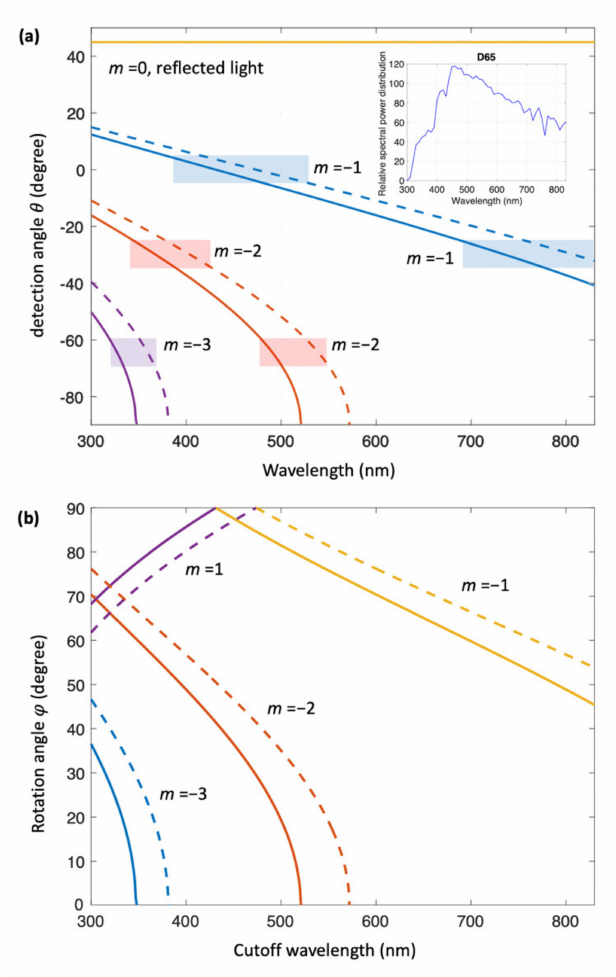
Figure 5. ( a ) Calculated m th order diffraction angles as a function of the wavelength of light. The ranges of the wavelength detected by three detection angles of 0 ◦ , − 30 ◦ , and − 65 ◦ are described by rectangular boxes filled with blue, red, and purple for m = − 1, − 2, and − 3, respectively. For these boxed regions, the CIE 10 ◦ 1964 standard observer and a groove period range of 610–670 nm are considered. ( b ) Rotation angle ϕ versus the cutoff wavelengths for m = − 3, − 2, − 1, and 1. Solid and dashed lines are used to describe the cases with groove periods of 610 and 670 nm,